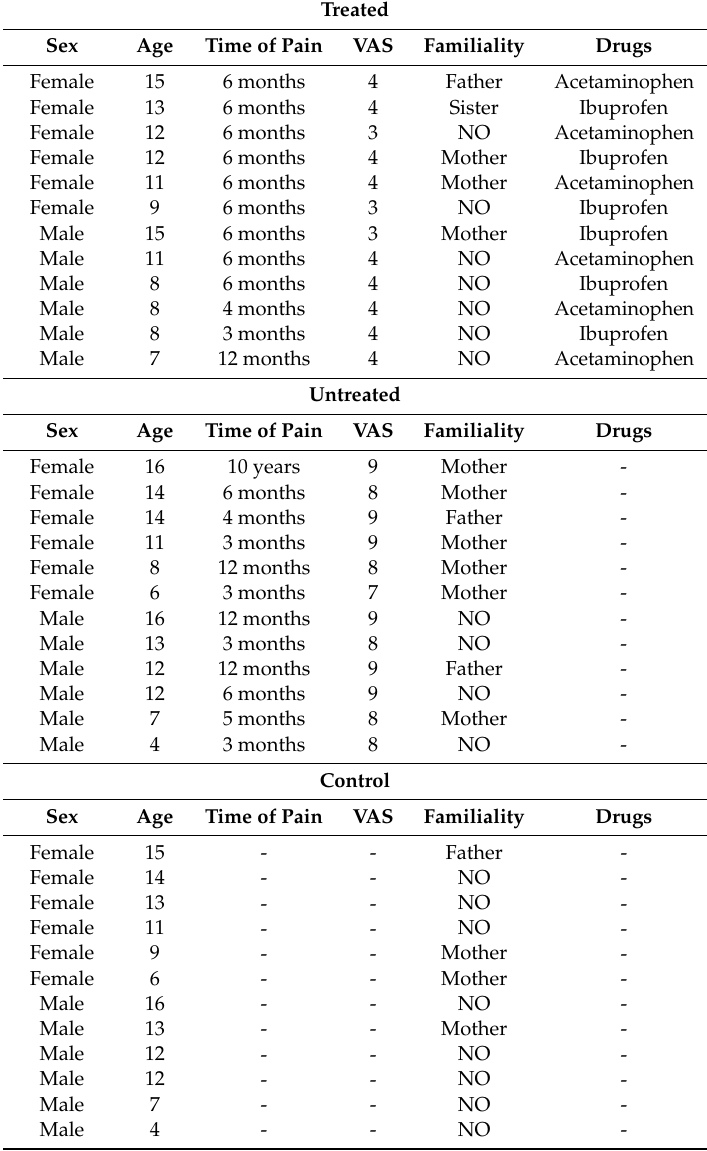
Table 1. Clinical characteristics of treated and untreated groups of subjects with migraine without aura (MWA) and healthy group without MWA, herein named control, enrolled in our study. Patients enrolled in treated group (acetaminophen (15 mg / kg) or ibuprofen (10 mg / kg) during the acute attack) underwent also to supportive therapy with magnesium (400 mg / day for 3